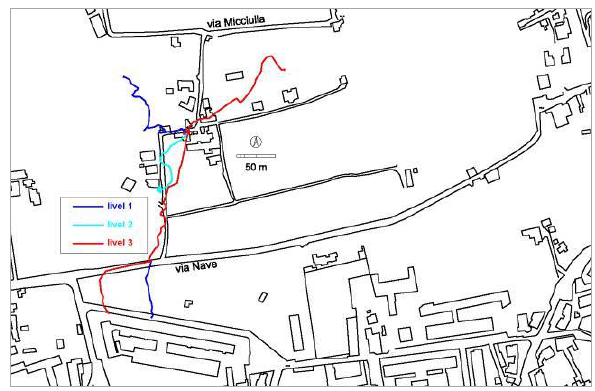
Figure 2. “Corso Gesuitico Alto” in the urban context. (Survey: Gruppo Speleo CAI Palermo. Graphic restitution: INS Salvatore Sammataro, INS Silvia Sammataro -